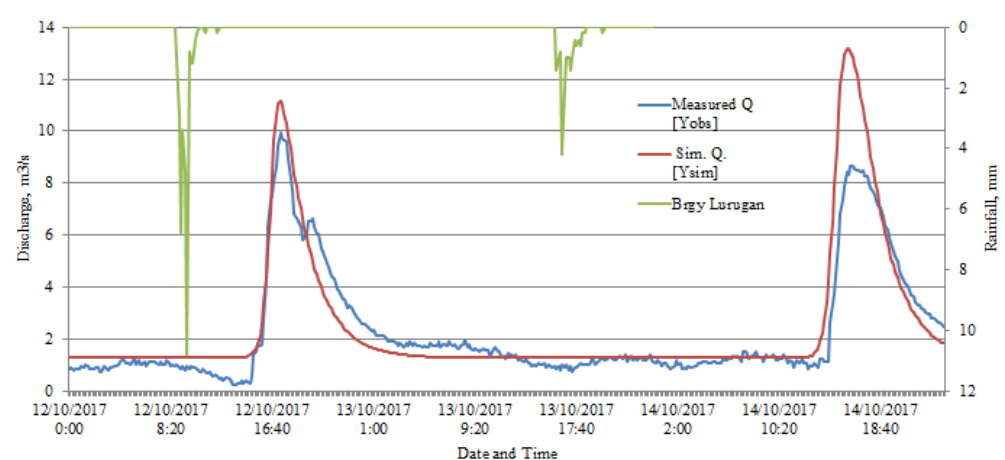
Fig. 6: Calibration result of Malingon river basin HEC-HMS model using the observed discharge